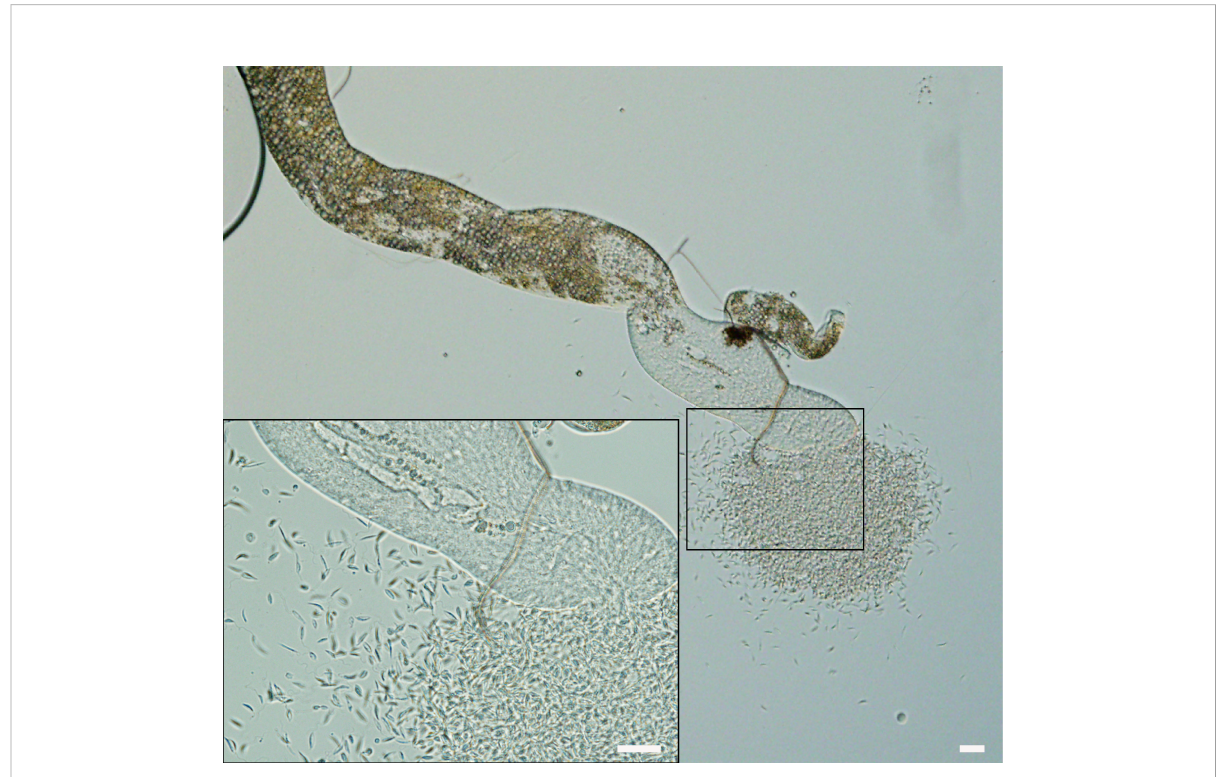
FIGURE 4 Porcisia deanei colonizing Malpighian tubules of L. longipalpis on day 7 PBM. Scale bars indicate 20